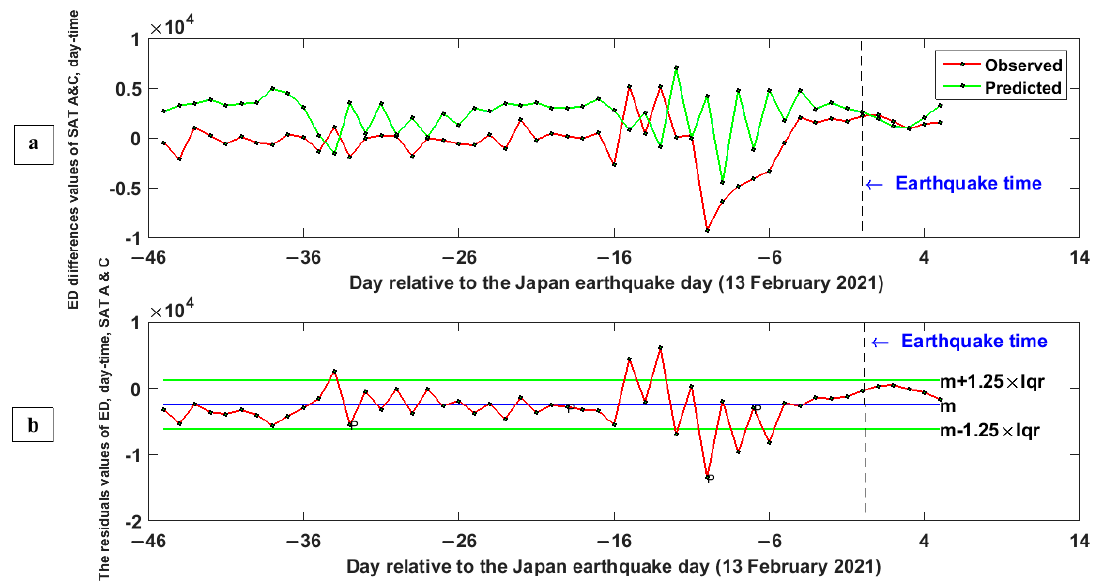
Figure 7. ( a ) Variations of the observed (red curve) and the predicted (green curve) values of the differences between the electron density (ED) values measured by satellites A and C obtained by the LSTM method during testing days at day-time. ( b ) Variations of the differences between the observed values of the electron density (ED) values measured by satellites A and C and predicted values obtained by the LSTM method during testing days at day-time. The geomagnetically “perturbed” days are highlighted by a “P”. Please note that here the values are not given as their natural logarithm. Table 2. The observed anomalies from 45 days before the earthquake using the Median/Interquartile method. Detected Anomalies Using Median/Interquartile Method Satellite